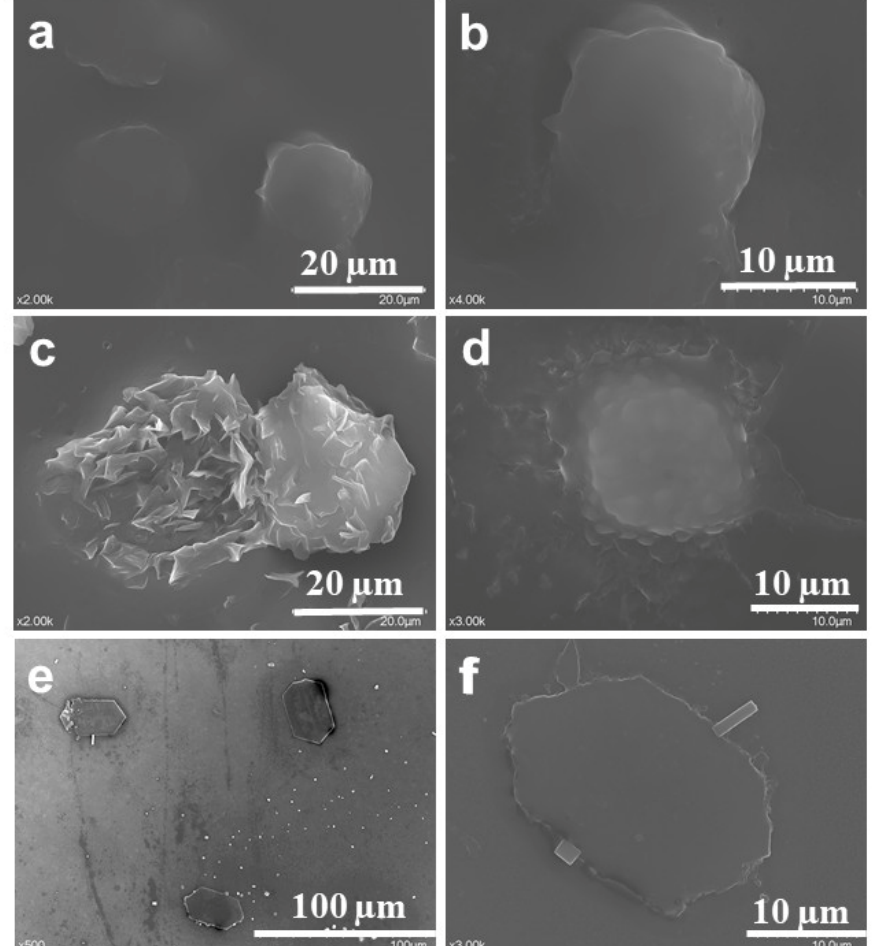
Figure 5. SEM microimages of Lmp ( a , b ), Lmp/Dexa ( c , d ), and Dexa crystals ( e,f ) from the superna- tant separated after Lmp/Dexa sedimentation.2.3. Lmp/Dexa